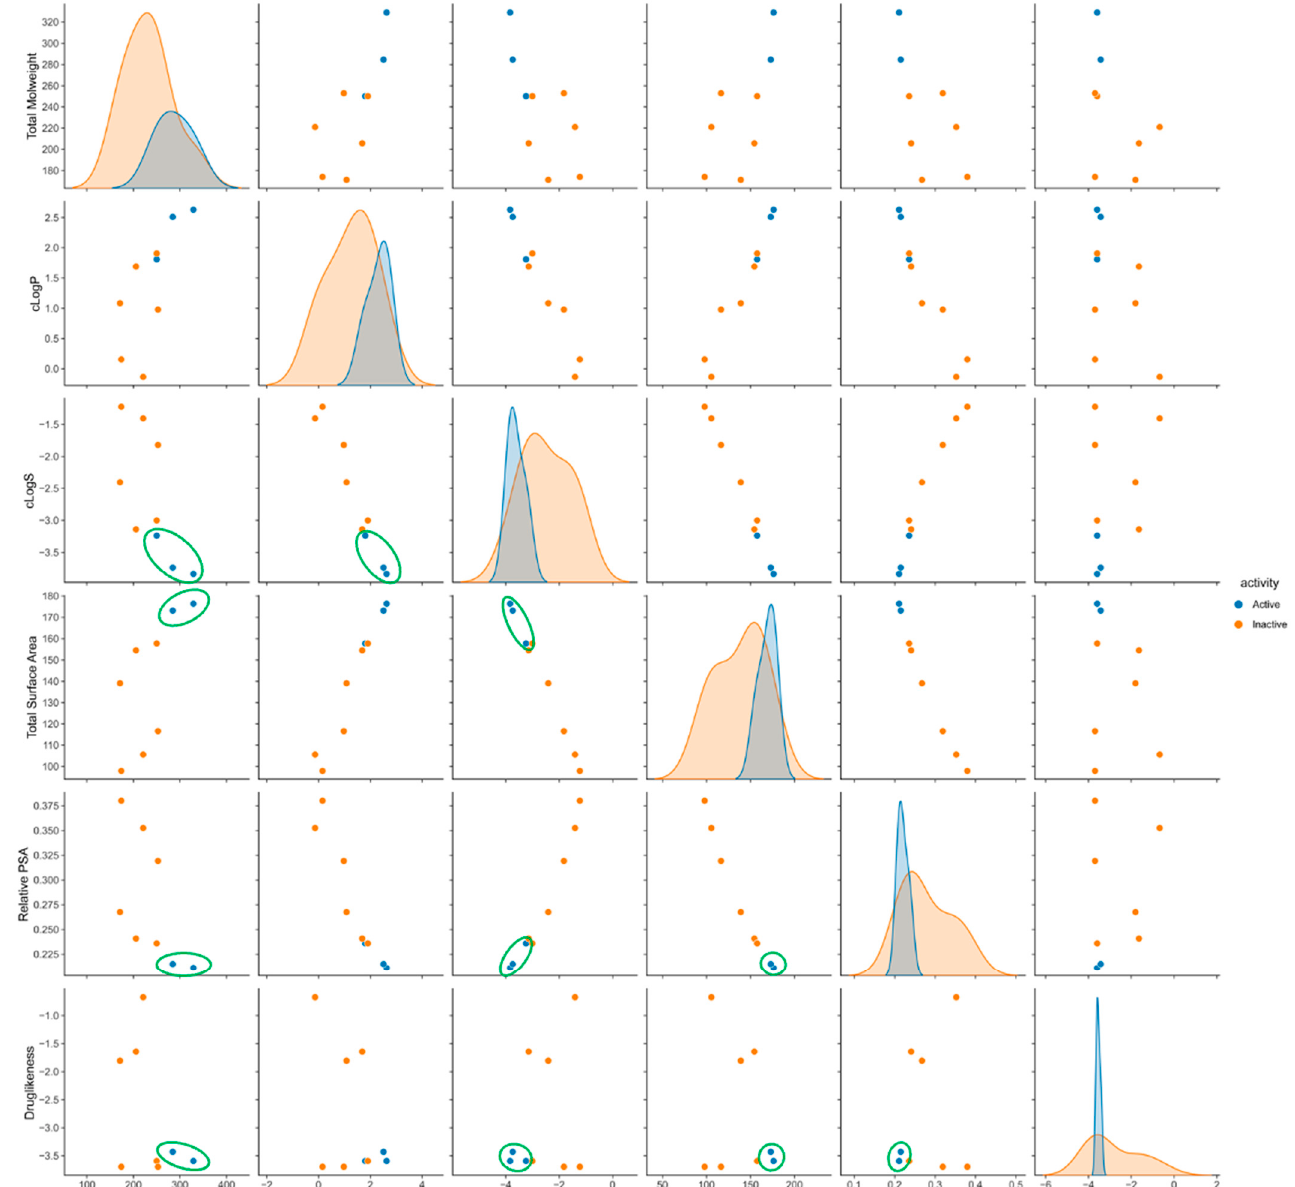
Figure 9. Pair plot representation of selected chemical features of Br-Clm derivatives. Orange: inactive towards AGS cells; blue: top three active molecules.